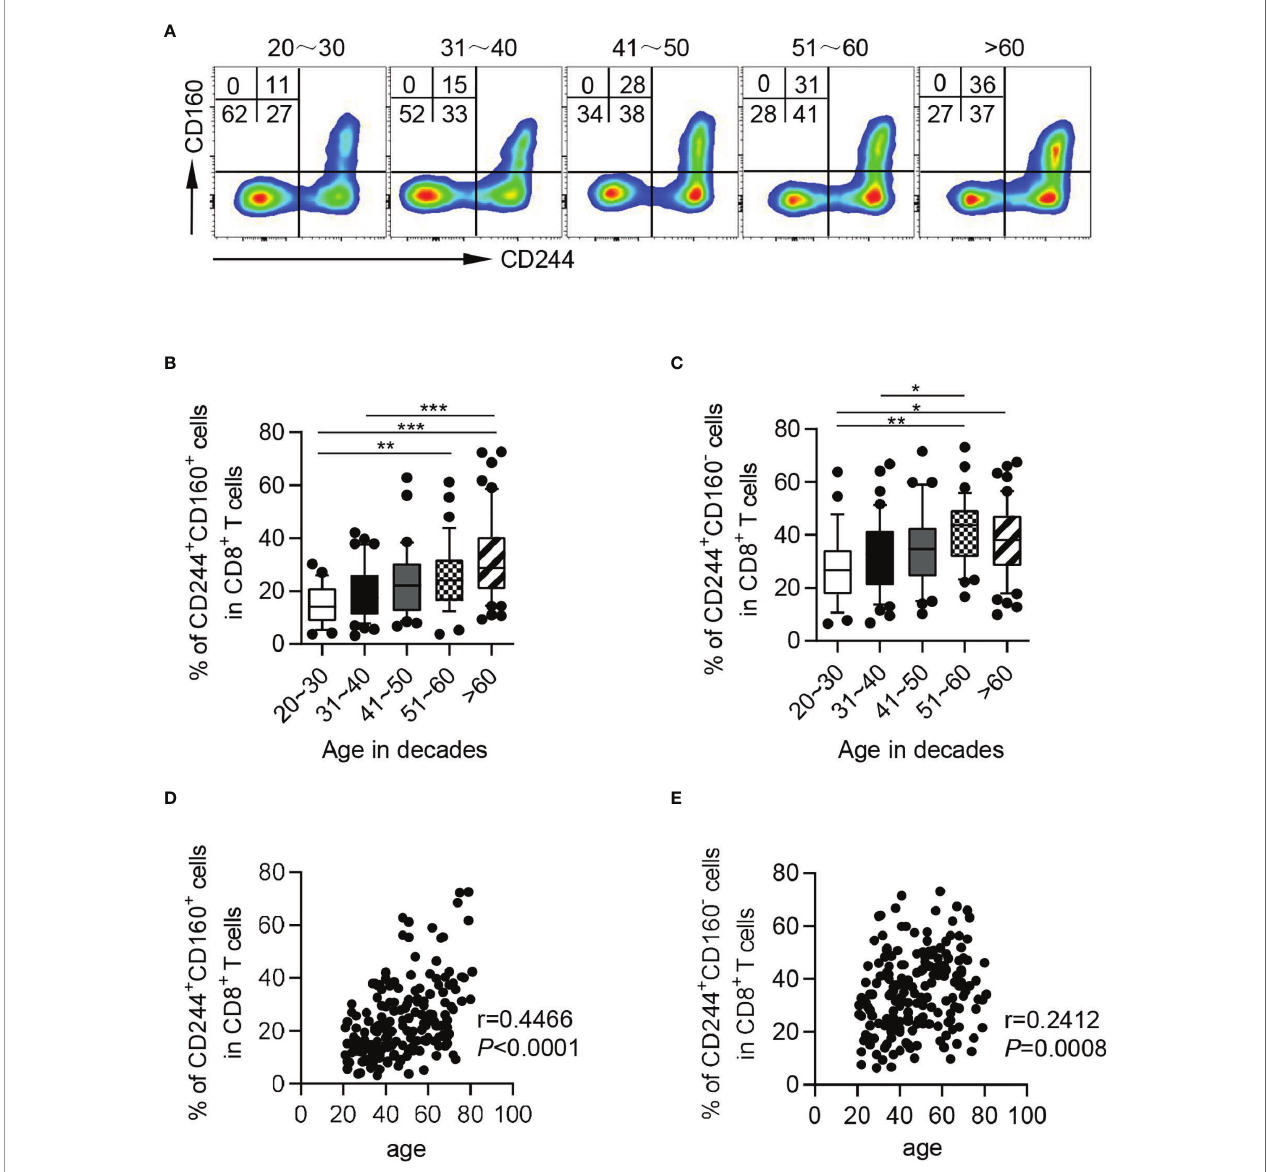
FIGURE 2 | The frequencies of CD244 + CD160 + and CD244 + CD160 - CD8 + T cells in healthy individuals from different age groups. Flow cytometry analysis of frequencies of CD244 + CD160 + and CD244 + CD160 - CD8 + T cells from healthy donors of different ages. (A) Representative fl ow data show the frequencies of CD244 + CD160 + and CD244 + CD160 - cells gated on CD8 + T cells from fi ve healthy donors in different age groups. (B, C) Box plots of the percentage of CD244 + CD160 + (B) and CD244 + CD160 - (C) cells on CD8 + T cells from healthy donors in different age groups (n = 27-50 each group). P values were obtained by one-way ANOVA followed by Tukey ’ s multiple comparisons test. (D, E) Correlation analysis of age and the percentage of CD244 + CD160 + (D) , CD244 + CD160 - (E) CD8 + T cells from all healthy individuals. Spearman ’ s non-parametric test were used to test for correlations. * P < 0.05, ** P < 0.01, *** P <